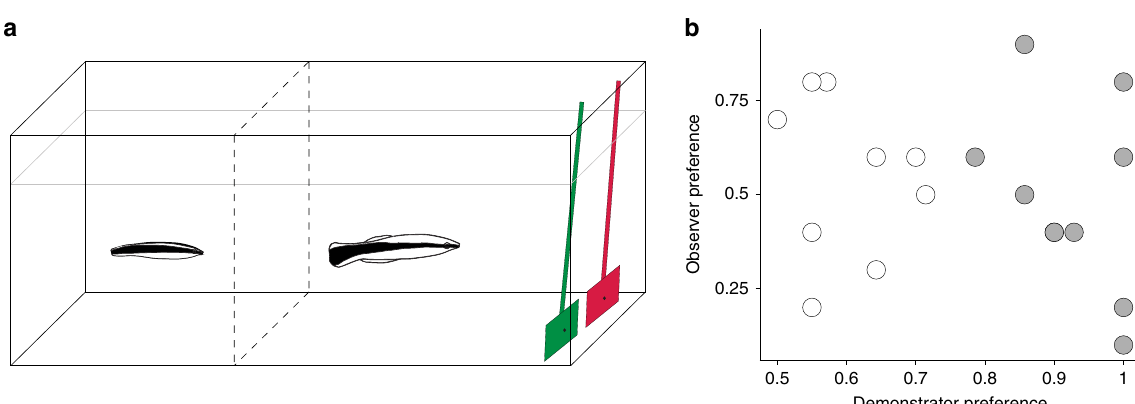
Fig. 4 Observers do not copy arbitrary preferences. Experiment 3, setup and results. a Demonstration phase setup. The compartments of juvenile and adult cleaners were separated via a transparent barrier, and in each demonstration session the juvenile cleaner (depicted on the left) could observe the adult making a choice between two differently colored plate types. The food was invisible to juveniles, located on the back of the plates (see black dots), and the plate not chosen was immediately retracted from the aquarium. b Plate preferences of juvenile observers during the test phase plotted against the preferences exhibited by their respective demonstrators in the training phase. Each dot depicts the proportion of choice of both the observer and demonstrator, for the plate that was more frequently chosen during demonstrations. Grey circles show the condition in which demonstrators had been trained to prefer one plate ( N = 10), white circles show the condition in which demonstrators had been trained to approach the plates at random ( N = 9). Source data are provided as a Source Data fi